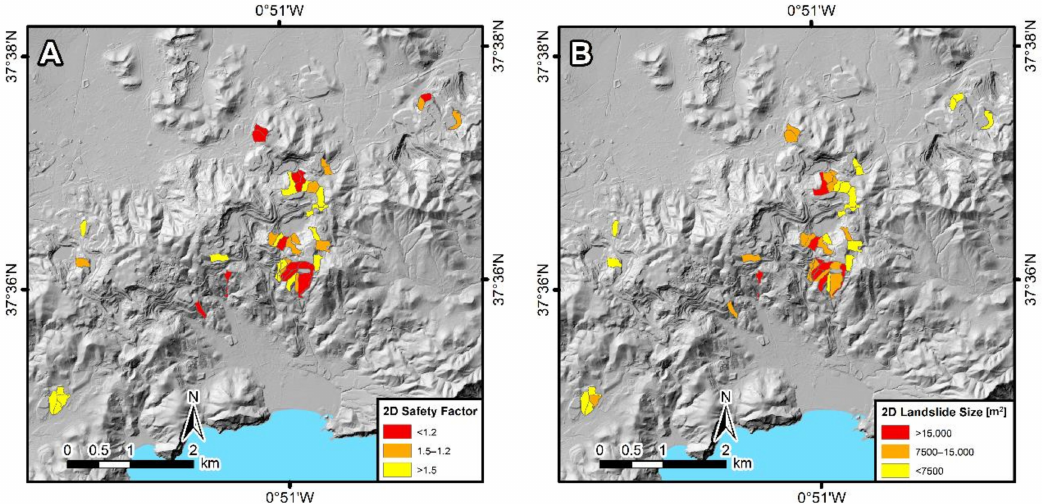
Figure 10. Results of the 2D stability analyses for the 43 active deformation slope units (ADSUs) from the optimal set (ADSU set 18). ( A ) 2D safety factors, and ( B ) 2D landslide